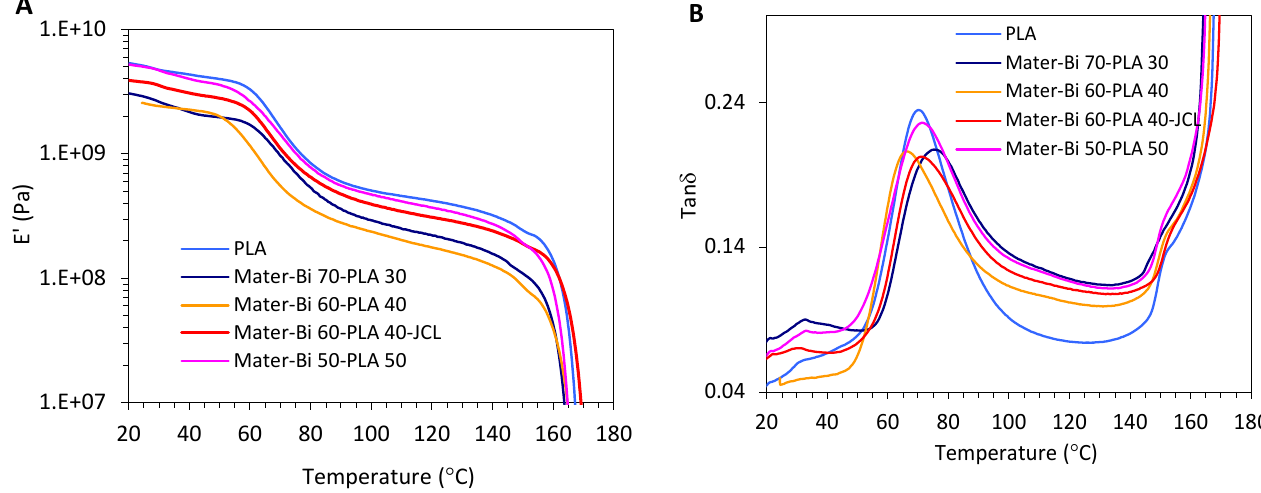
Figure 4. Plot evolution of the storage Modulus E’ ( A ), Tan δ ( B ) versus Temperature of Mater- Bi ® /PLLA blends after the annealing treatment at 80 °C for 15 min.